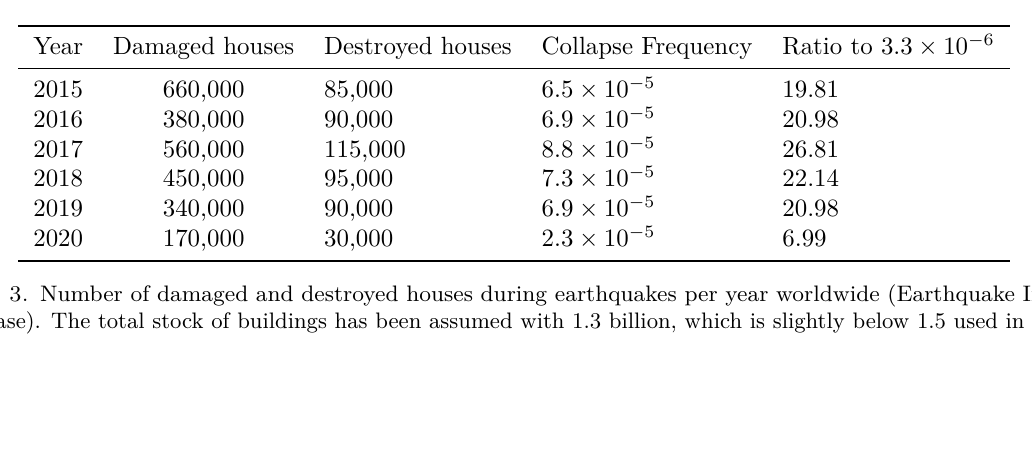
Table 2. Number of destroyed houses during large-scale accidental actions.